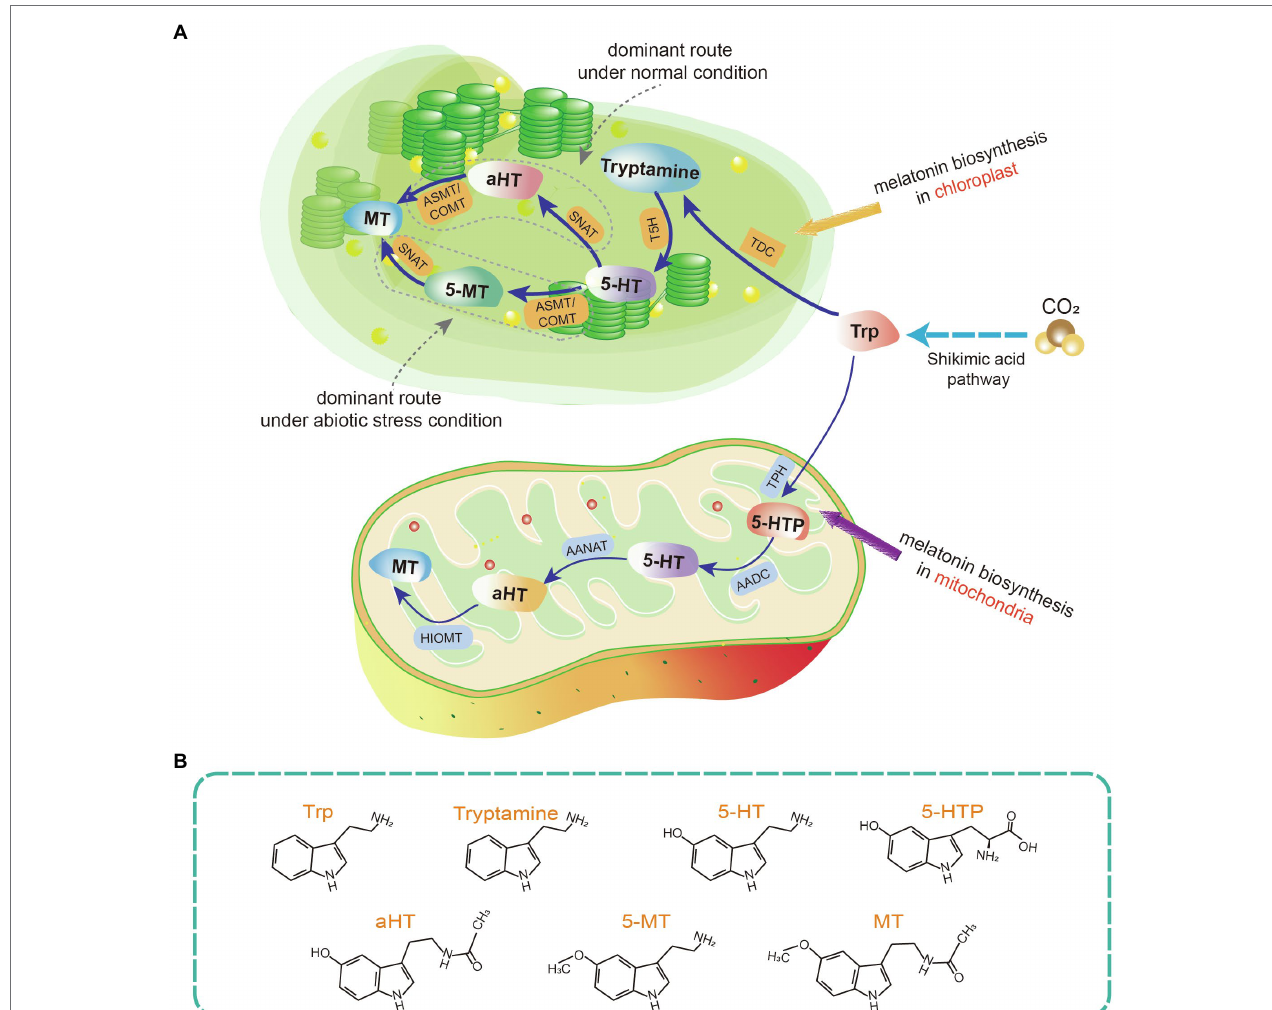
FIGURE 1 | Phytomelatonin biosynthetic pathway in chloroplasts and mitochondria. (A) Schematic of melatonin biosynthetic pathways. (B) Molecular structures of key intermediate products in the melatonin biosynthetic pathway. Plants usually synthesize melatonin in chloroplasts under normal conditions. If this pathway is blocked, melatonin biosynthesis may be switched to the mitochondria. Trp, tryptophan; 5-HT, 5-hydroxytryptamine; 5-HTP, 5-hydroxytryptophan; aHT, N-acetyl-5- hydroxytryptamine; 5-MT, 5-methoxytryptamine; MT, melatonin; TDC, tryptophan decarboxylase; T5H, tryptamine 5-hydroxylase; SNAT, serotonin N-acetyltransferase; ASMT, N-acetylserotonin-O-methyltransferase (plant type SNATs and ASMTs appear to have origins distinct from the origins in animals); COMT, caffeic acid O-methyltransferase; TPH, tryptophan hydroxylase; AADC, aromatic amino acid decarboxylase; AANAT, arylalkylamine N-acetyltransferase (also known as arylamine N-acetyltransferase); and HIOMT, hydroxyindole-O-methyltransferase (also known as N-acetylserotonin